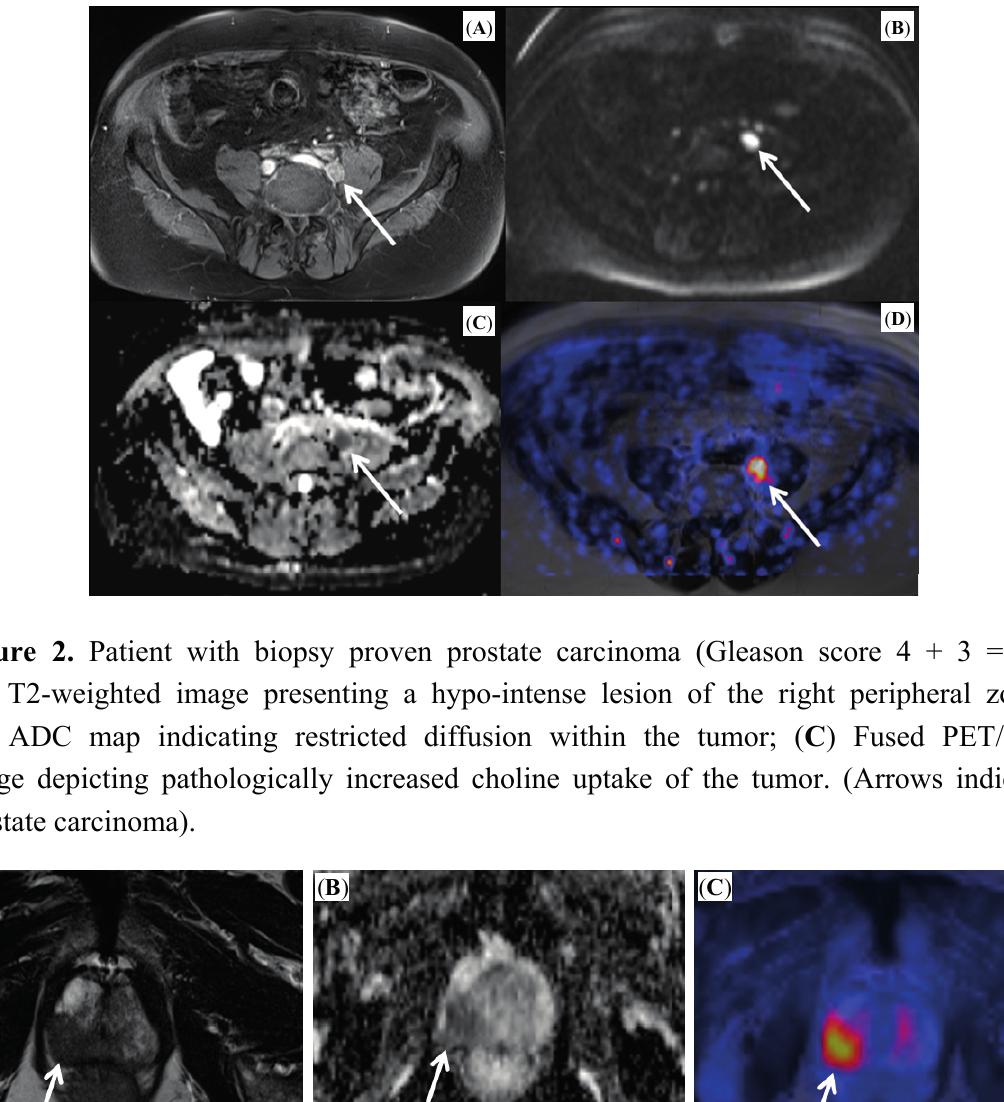
Figure legends: Images from a patient with biochemical failure after radical prostatectomy (Figure 1) and from a patient with histological proven prostate carcinoma (Figure 2). [ 18 F] choline PET/MR imaging was performed after PET/CT. The images illustrate the combined findings of anatomical sequences together with diffusion-weighted imaging and PET imaging. Figure 1. Patient with a lymph node metastasis from prostate cancer. ( A ) T1-weighted image after administration of contrast medium showing an enlarged left iliac lymph node with contrast enhancement; ( B ) Diffusion-weighted images revealing a diffusion restriction of the lymph node indicated by a hyper-intense signal; ( C ) Corresponding apparent diffusion coefficient (ADC) map with hypo-intense depiction of the lymph node; ( D ) Fused PET/MR image with pronounced choline uptake of the lymph node. (Arrows indicate lymph node metastasis).